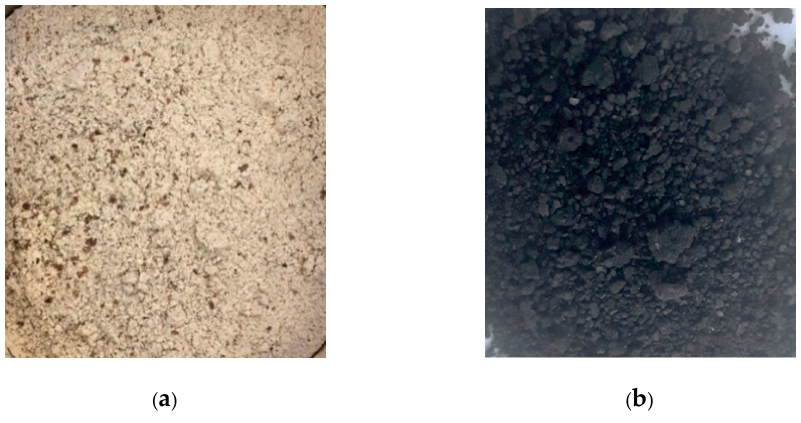
Figure 1. ( a ) Ground chestnut before pyrolysis, ( b ) biochar—chestnut after pyrolysis